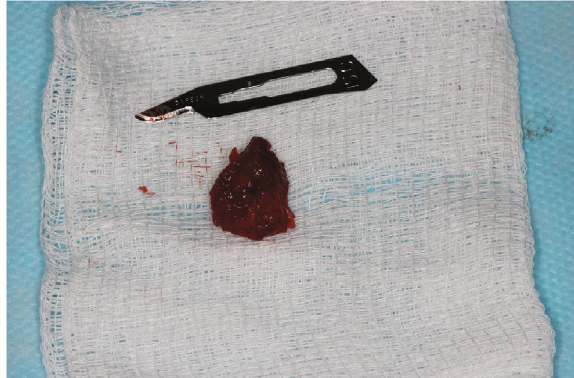
Figure 6: Total enucleation without compromising the